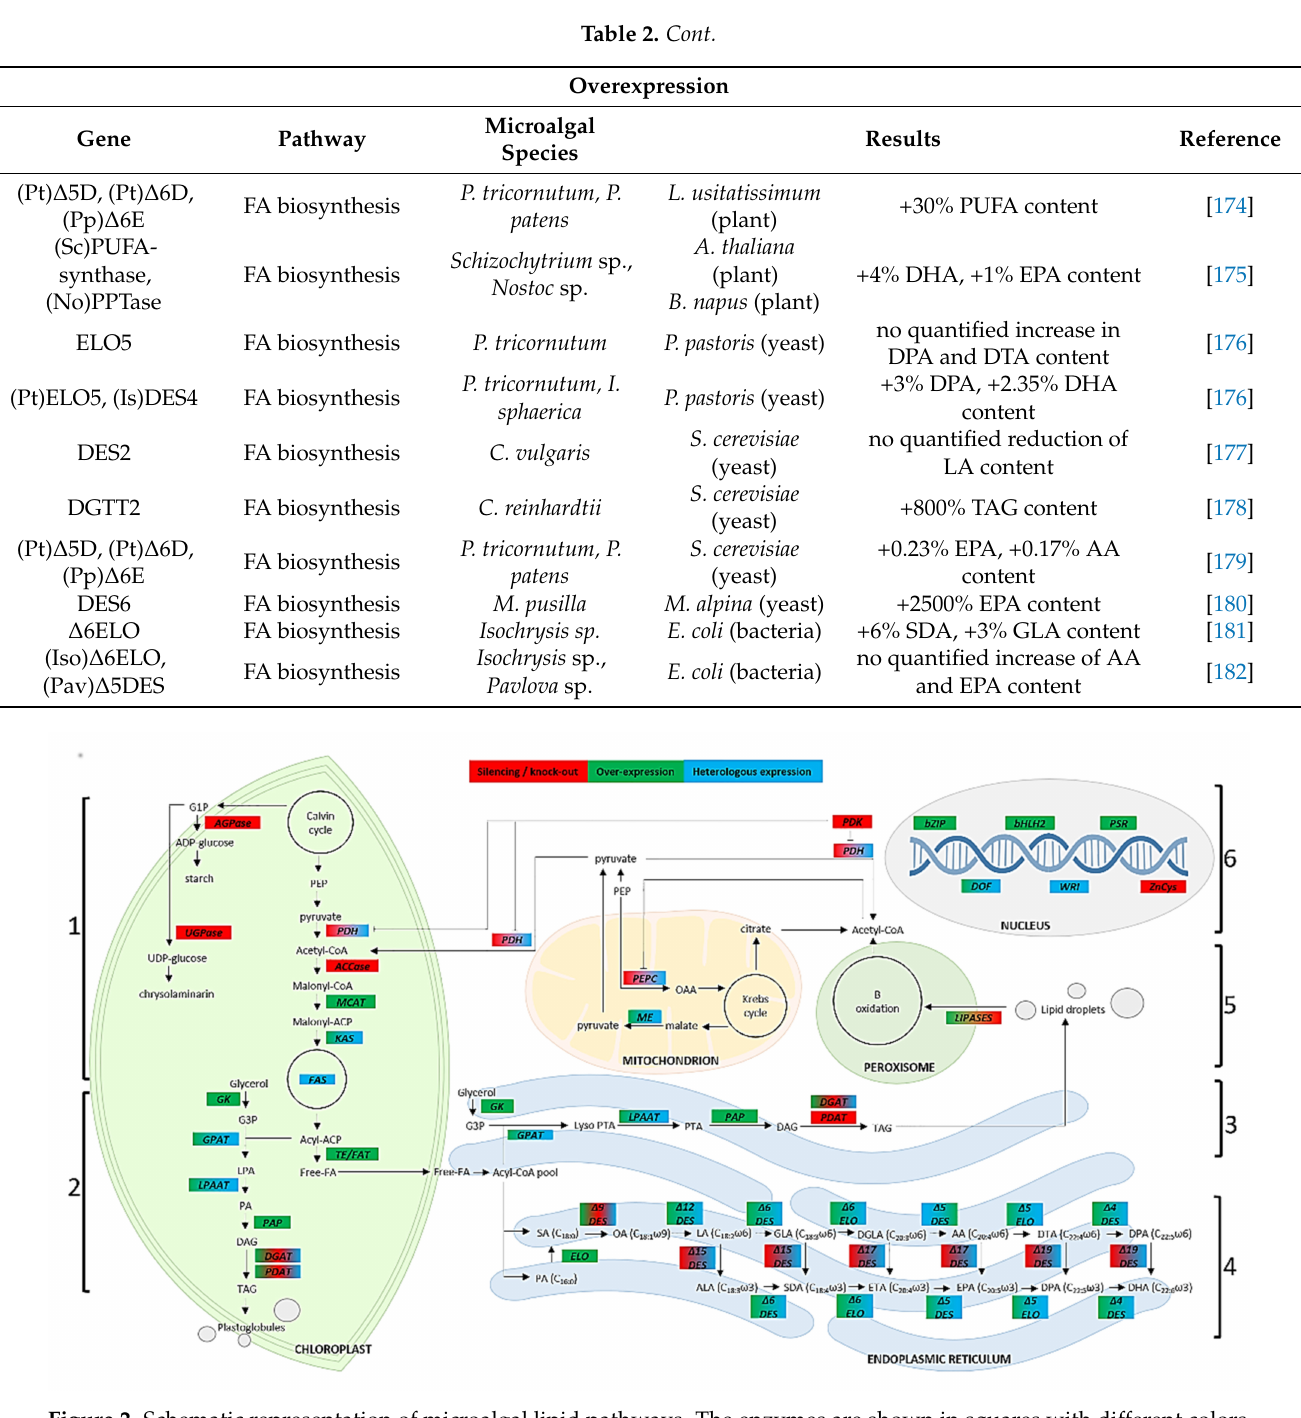
Figure 2. Schematic representation of microalgal lipid pathways. The enzymes are shown in squares with different colors, depending on the genetic manipulation that occurred: red for silencing or knock-out, green for overexpression, and blue for heterologous expression. Cellular organelles involved are plastid, endoplasmic reticulum, peroxisome, mitochondria cytosol, and nucleus. The numbers (from 1 to 6) near the square brackets indicate different figure sections. AA: Arachidonic Acid; ACCase: Acetyl-CoA Carboxylase; ACP: Acyl Carrier Protein; ADP-glucose: Adenosine-Diphosphate Glucose; AGPase: ADP-Glucose Pyrophosphorylase; bHLH2: Basic Helix-Loop-Helix transcription factor 2; bZIP: Basic